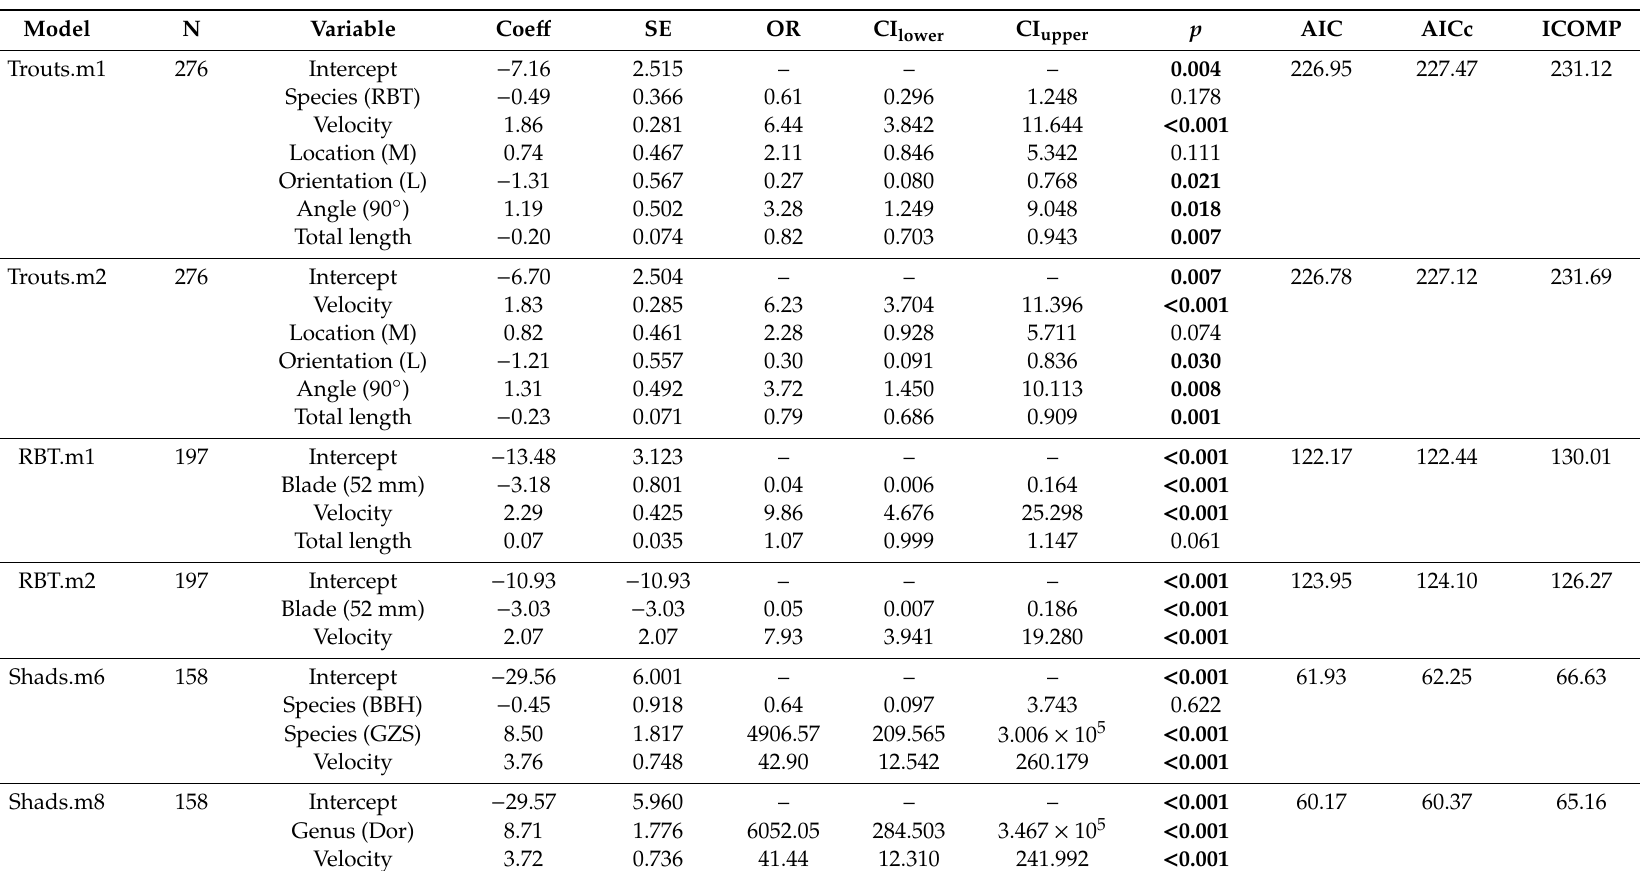
Table 2. Results of a logistic regression of mortality and strike impact conditions including adult rainbow trout and brook trout data (Trouts), small and large rainbow trout (RBT), and data for gizzard shad, American shad, and blueback herring (Shads). Model Trouts.m1